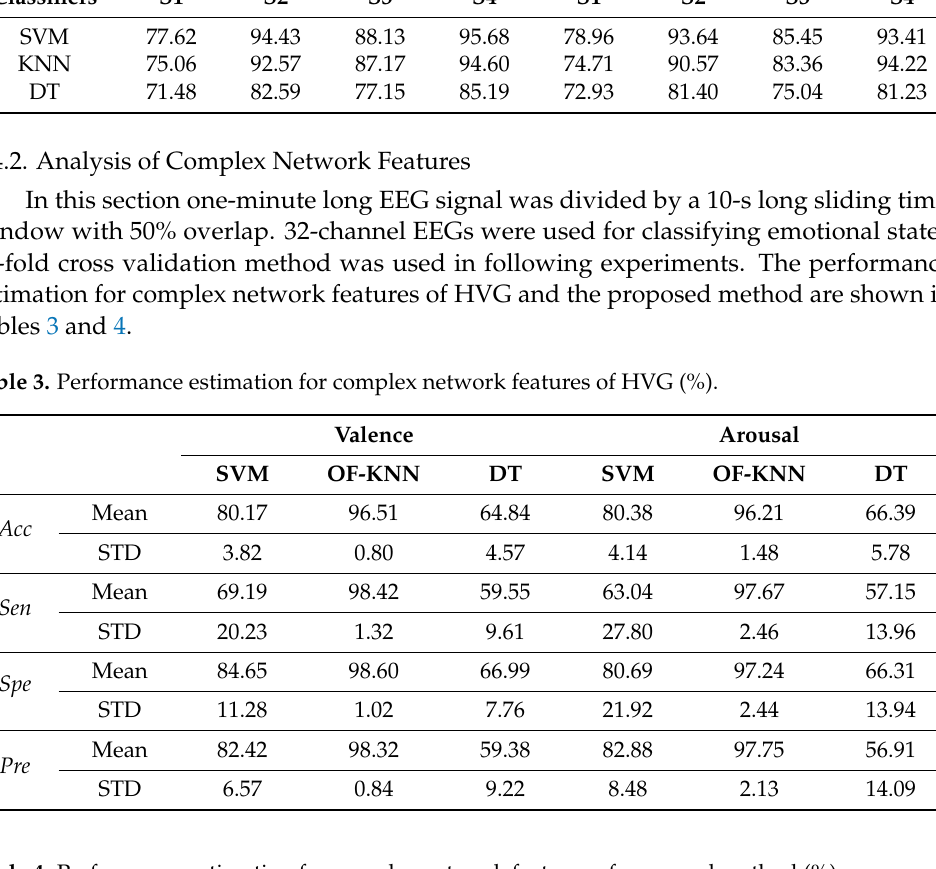
Table 4. Performance estimation for complex network features of proposed method